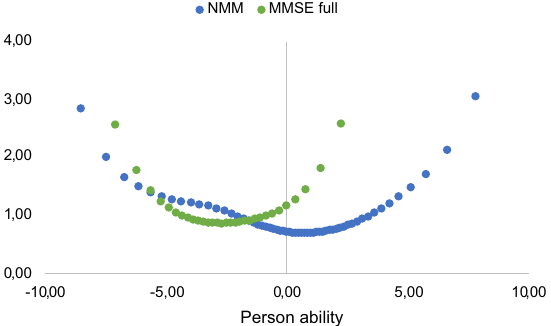
Figure 5. Measurement uncertainties, 2SE, on the y-axis and person ability measures (θ) on the x-axis compared for measures based on the NMM (lowest blue dots) and one (MMSE) of the legacy tests. Larger values of θ correspond to higher person